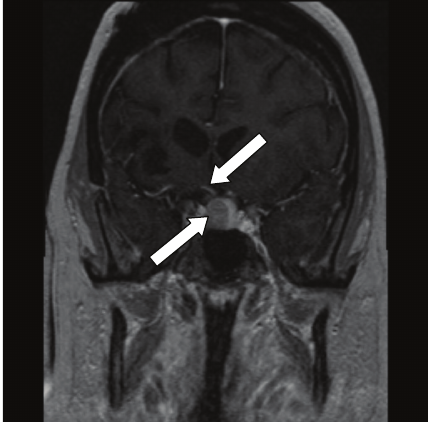
Figure 2: MRI of pituitary (coronal view) (arrows showing the macroadenoma and stalk deviation).